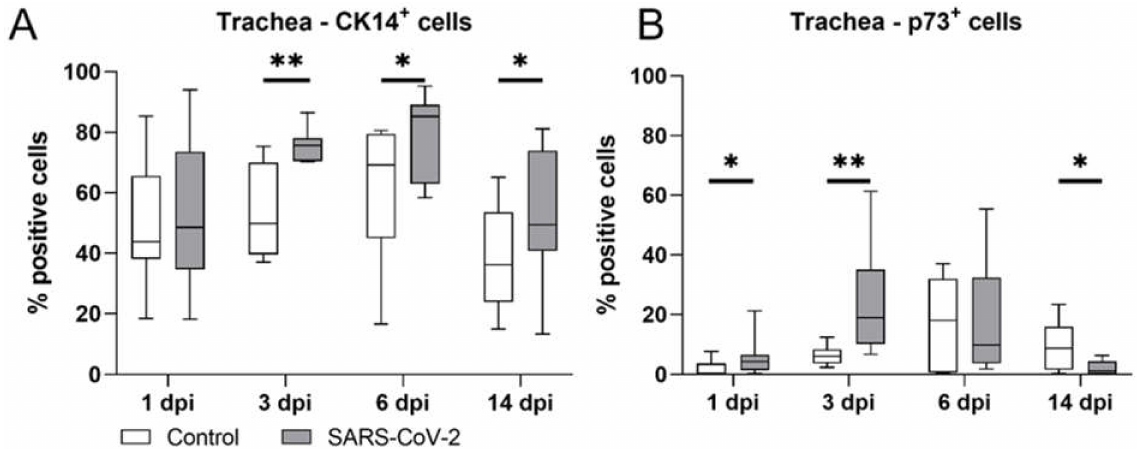
Figure 6. Histologic quantification of CK + and p73 + immunolabelled cells in tracheal cross-sections. ( A ) Immunolabeling of CK14 + basal cells in SARS-CoV-2-infected animals revealed significant in- creases at 3, 6, and 14 days post-infection (dpi) in positive cells compared with controls. ( B ) Immuno- labeling of p73 + basal cells in SARS-CoV-2-infected animals revealed significant increases in positive cells at 1 and 3 dpi and a significant decrease in positive cells at 14 dpi compared with controls. Box and whisker plots show medians, quartiles, and ranges. Asterisks indicate significant differences: * p < 0.05, ** p < 0.01,